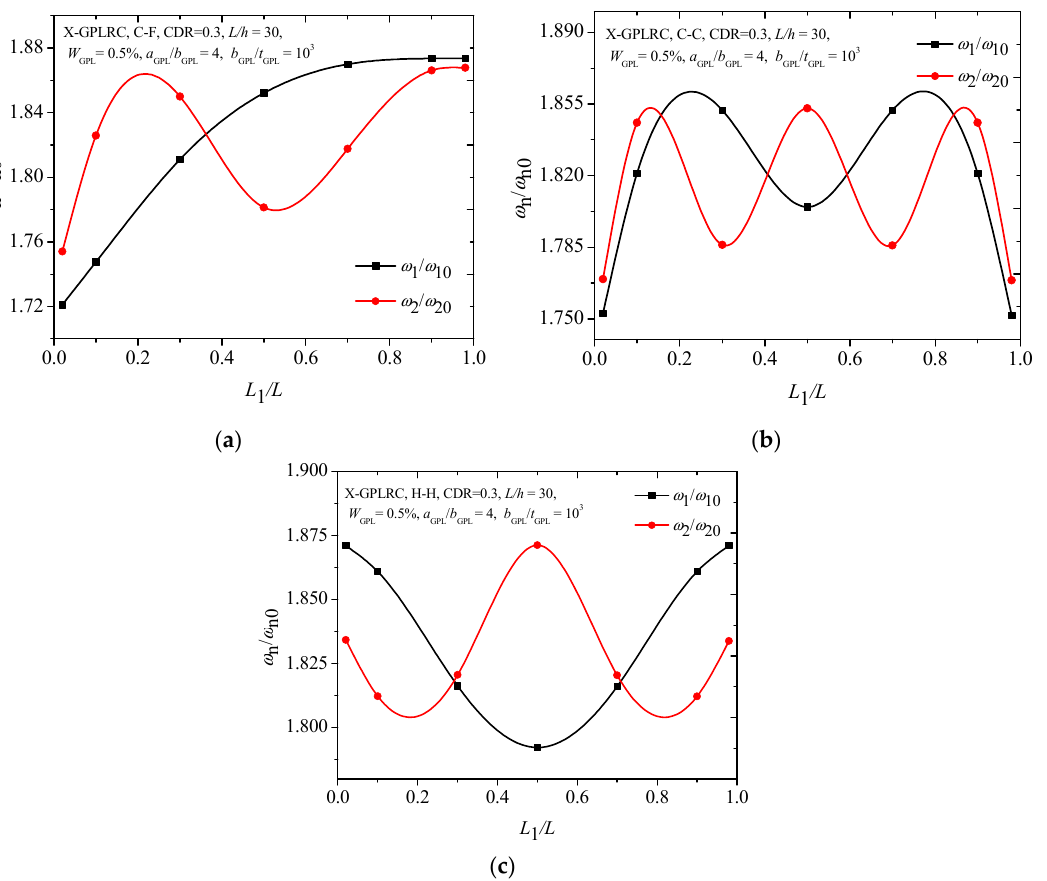
Figure 6. First two frequencies ratios of cracked FG-X-GPLRC beams with different boundary conditions: ( a ) C-F, ( b ) C-C, ( c ) H-H.